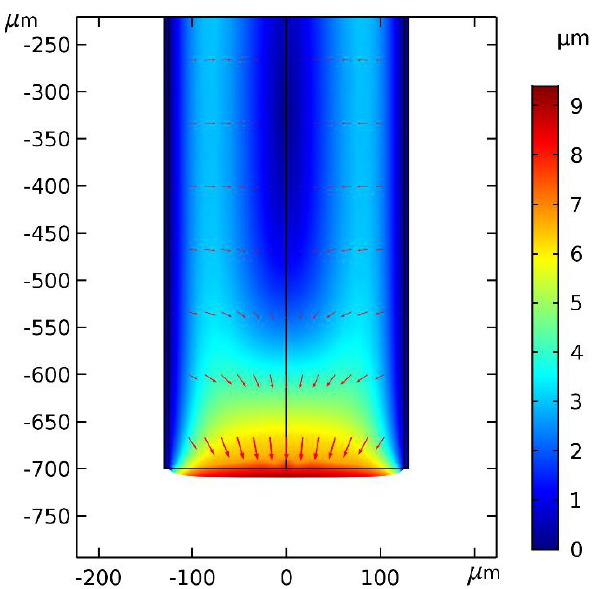
Figure 4. COMSOL Multiphysics 5.3a simulation of PMMA total displacement (surface) and displacement field (arrow surface) after 100 s for the POF dipped 700 µm into DBM. Involved physics in the simulation: Transport of diluted Species, Solid Mechanics and Hygroscopic Swelling. Swelling is assumed isotropic. Dissolution (free PMMA molecules) is not included in the simulation. We assume no movement of the cladding. Real values for DBM diffusion constants, hygroscopic swelling coefficient, solubility in Poly(vinylidene difluoride) (PVDF), and PMMA are not known, but also not important for illustration of the combined mechanism. However, in the shown simulation, diffusion constants for DBM was assumed to be 5 ∙ 10 −12 m 2 /s in PMMA perpendicular to the fiber axis and in the PVDF cladding. Along the fiber in PMMA it was assumed to be 5 ∙ 10 −14 m 2 /s. DBM concentration at all surfaces was at all times set to be equal to some arbitrary solubility of DBM in PVDF. From the simulated displacement field, it is seen, that PMMA was locally moved by swelling in directions and extents, which could very well lead to the CPC shape. This picture is unchanged if e.g., the diffusion is assumed to be isotropic and/or the cladding is thicker.